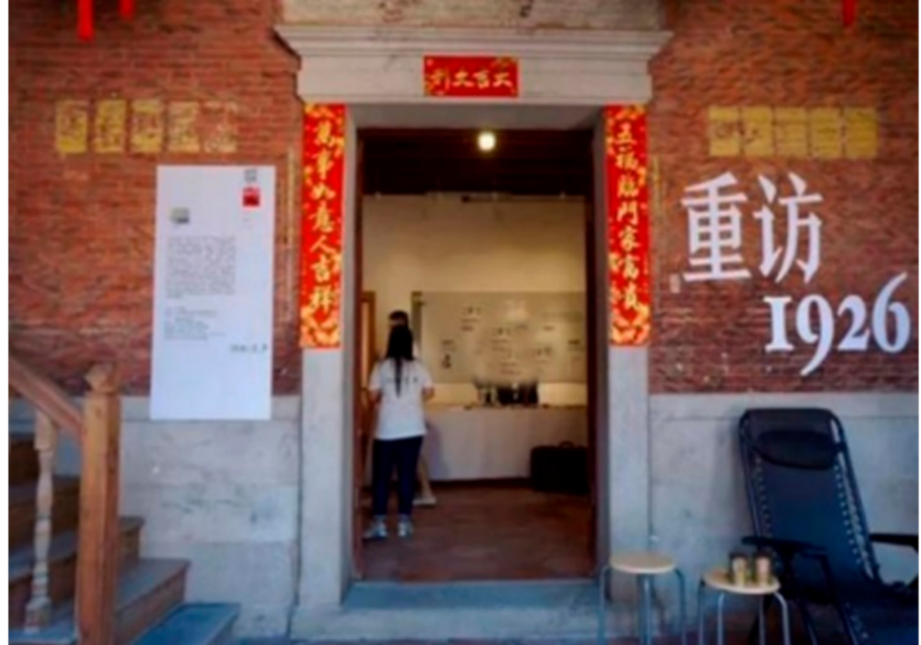
Figure 4. The “Revisiting 1926” activity self-organized by local youths. (Note: “Revisiting 1926” is a documentary exhibition, displaying old photos collected by local youths, whereby the meaning and value of cultural heritage is conveyed to the public so that they can have an understanding of history and a sense of